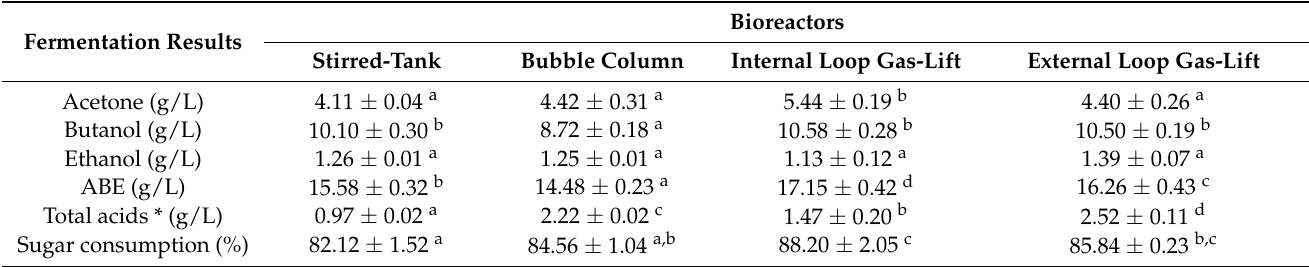
Table 3. Sugar consumption and product formation in ABE fermentations using various bioreactors after 36 h of